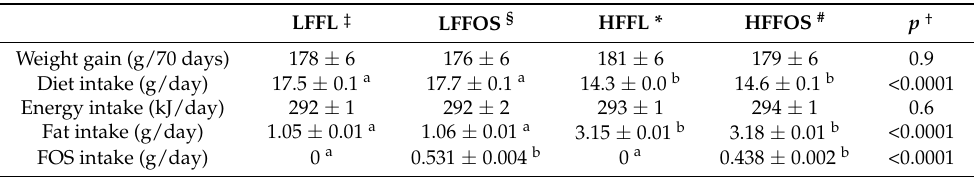
Table 1. Rat weight gain over 70 days and per day diet, energy, fat, and fructo-oligosaccharide (FOS) intake.